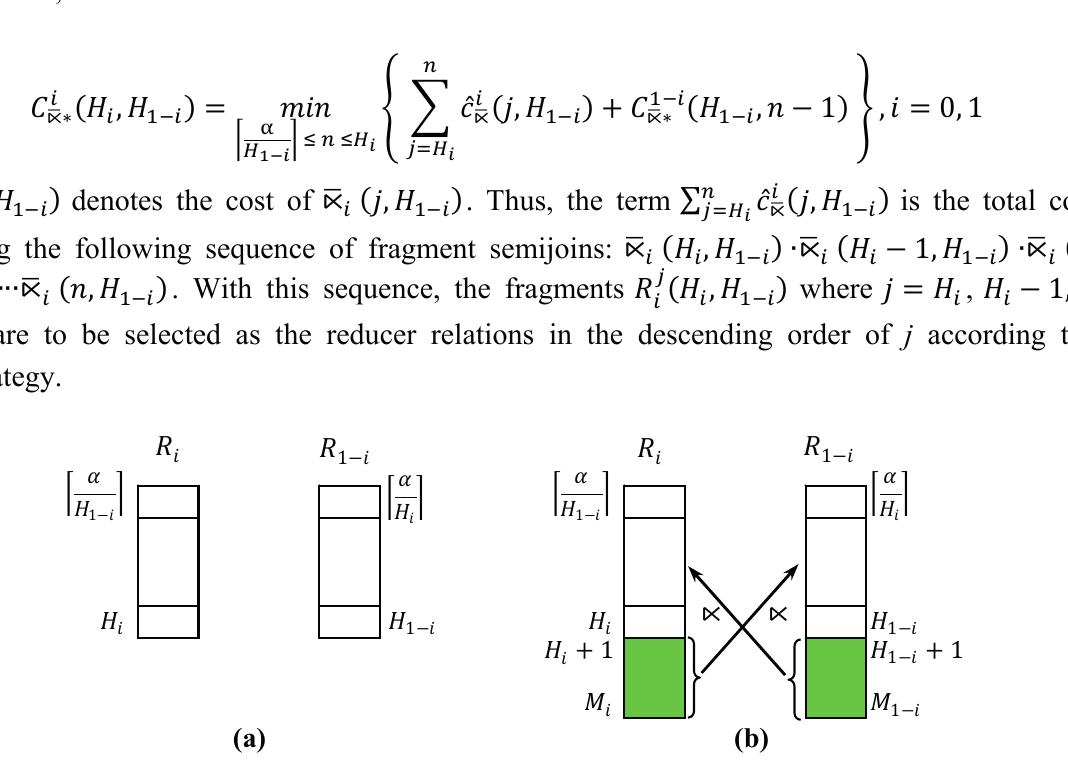
and (cid:2174) after a certain sequence of fragment semijoins has (cid:2191) (cid:2778)(cid:2879)(cid:2191)